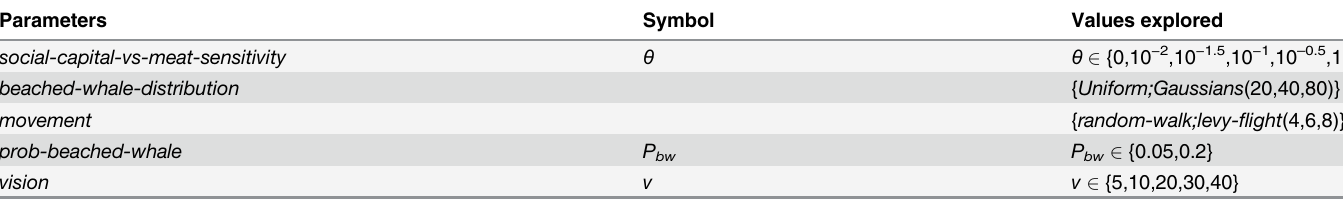
Table 6. Comprehensive design of